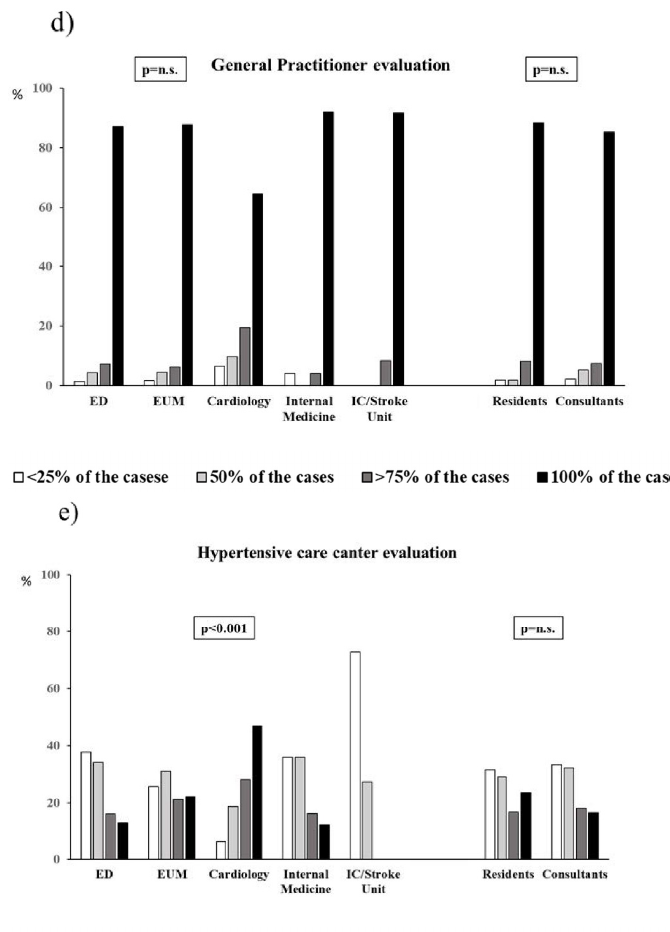
Figure 1. Prescribed follow ‐ up visits after hospital discharge by department and qualification level. ( a) Prescription of specialistic examination; (b)Prescription of Ambulatoory Blood Pressure Monitoring; (c) Prescription of home blood pressure monitoring; (d) Prescription of general practitioner evaluatiion; (e) Prescription of hypertensive care center evaluation. ED emergency Department; EUM Emergency and